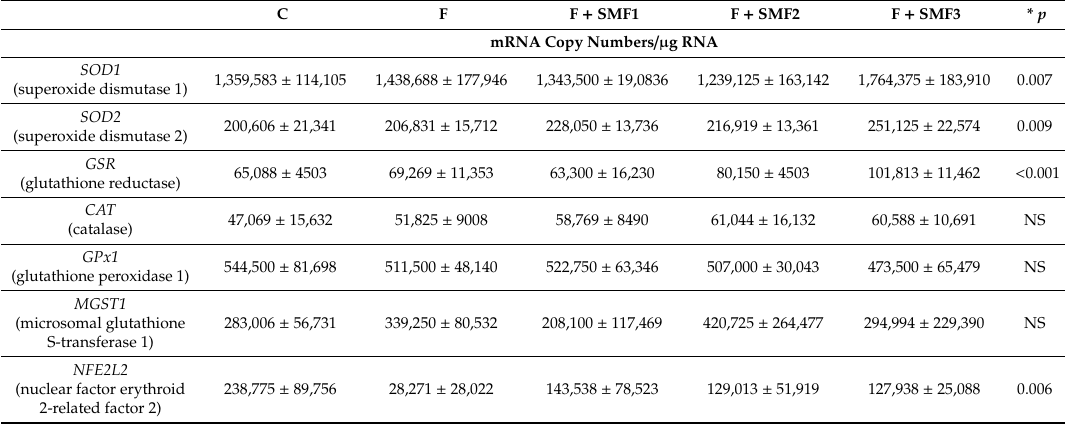
Table 1. The expression of the cellular antioxidant system-related genes in fluoride-treated fibroblasts and in fibroblasts that had been treated with fluoride, and then subjected to the influence of static magnetic fields (SMFs) of di ff erent intensities (0.45, 0.55, and 0.65 T) for 12 h compared to the control culture without fluoride and without the magnet (flux density 0.0